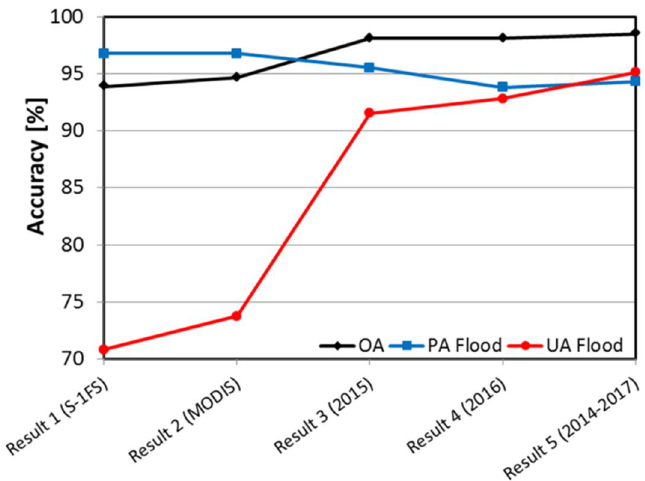
Figure 11. Overall (OA), User’s (UA), and Producer’s Accuracies (PA) of the flood masks produced by the Sentinel-1 Flood Service and of the improvements using the MODIS Landcover Class 16 and the SEL 60–100% computed with different time-series lengths.